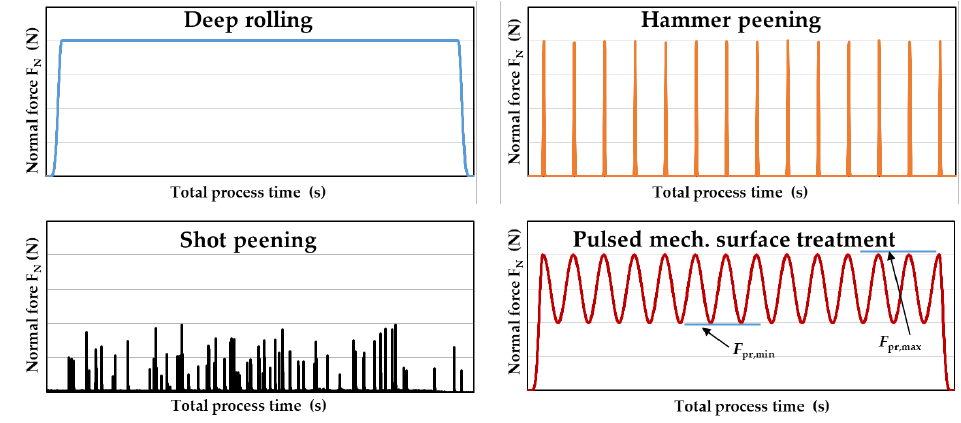
Figure 1. Theoretical comparison of time-based normal forces for four different processes with a mechanical main effect.